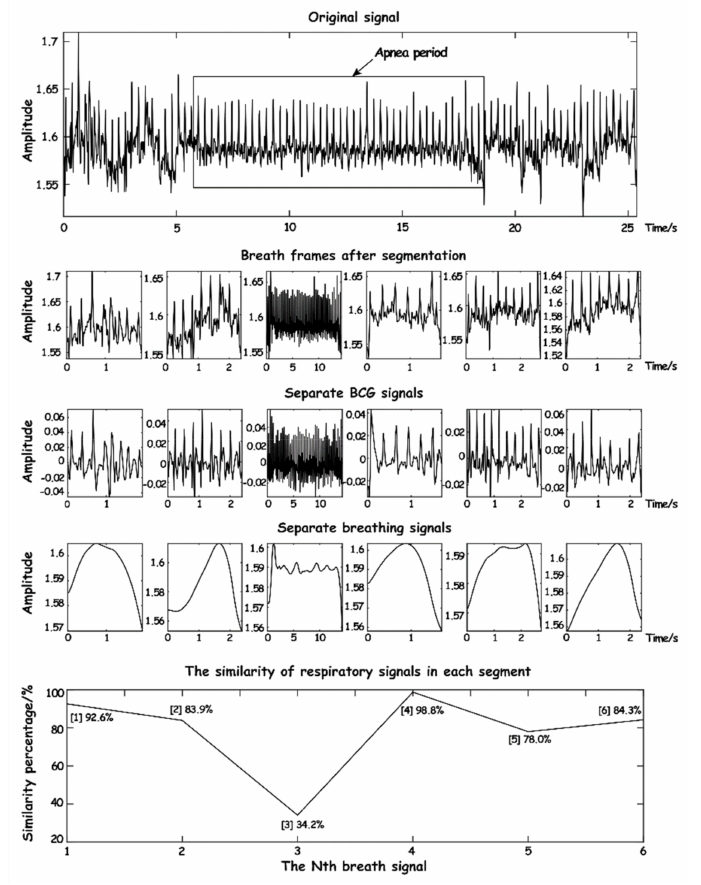
Figure 14. The schematic diagram of respiratory waveform